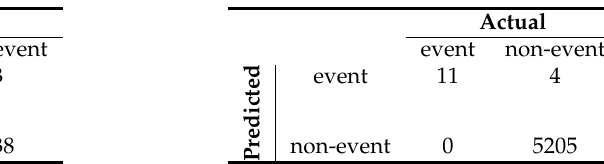
Table 11. Landing Distance Event (left) and Roll Event (right)– Confusion